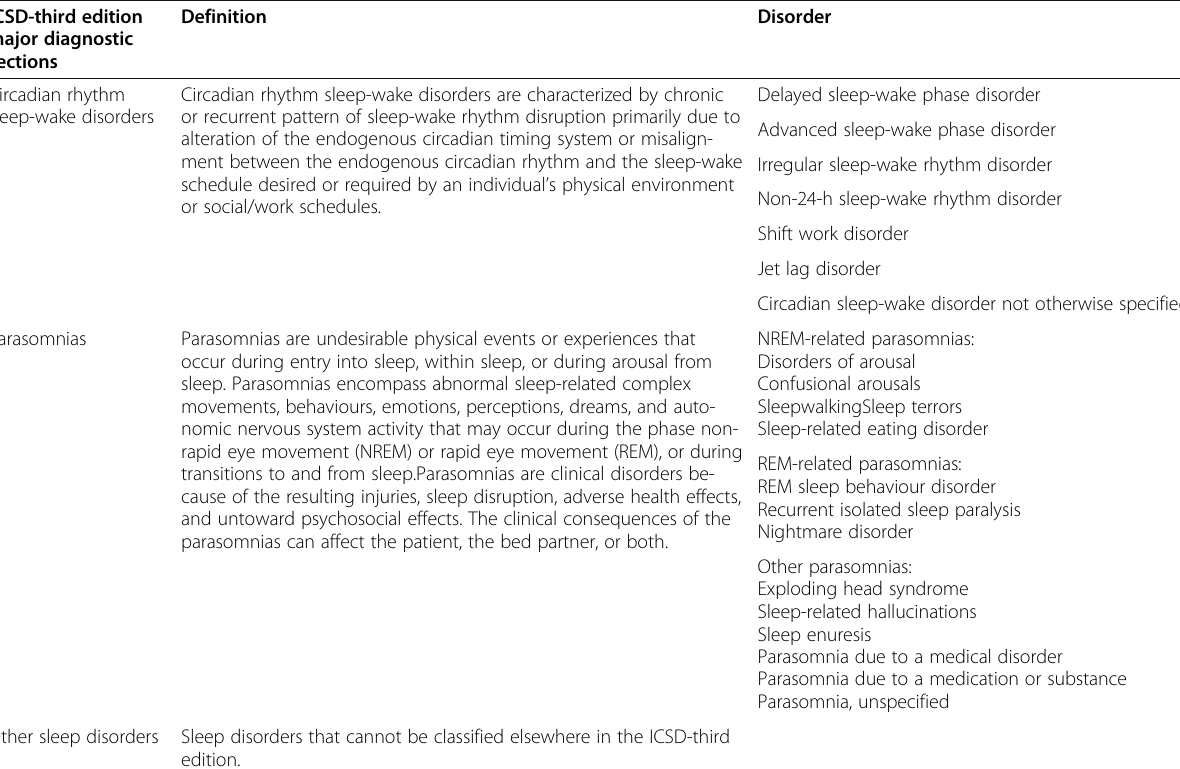
Table 1 Sleep disorders according to the International Classification of Sleep Disorders – third edition (Adapted from American Academy of Sleep Medicine. International Classification of Sleep Disorders. 3rd ed. Darien, IL: American Academy of Sleep Medicine; 2014 and from Sateia MJ. International classification of sleep disorders-third edition: highlights and modifications. Chest. 2014;146:1387 – 94.)